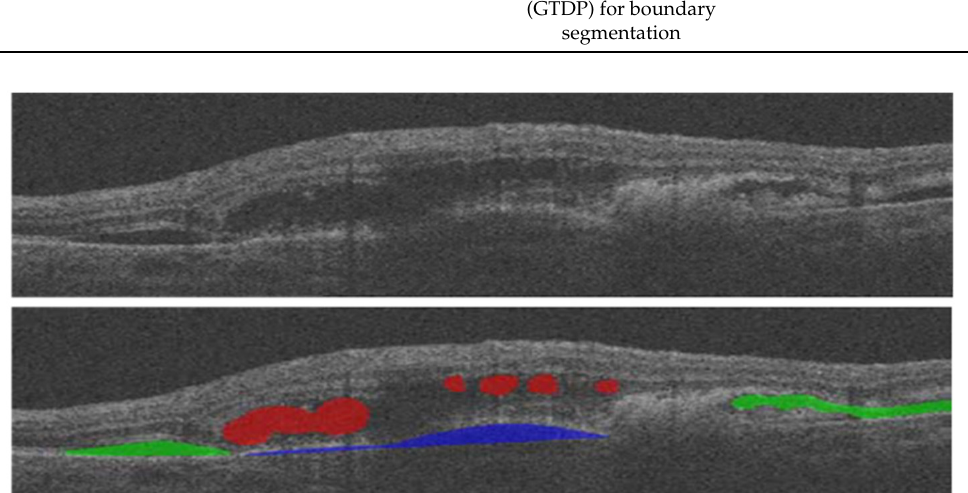
Figure 15. Various types of fluid detection shown in OCT. Table 3. Overview of related work in fluid segmentation.